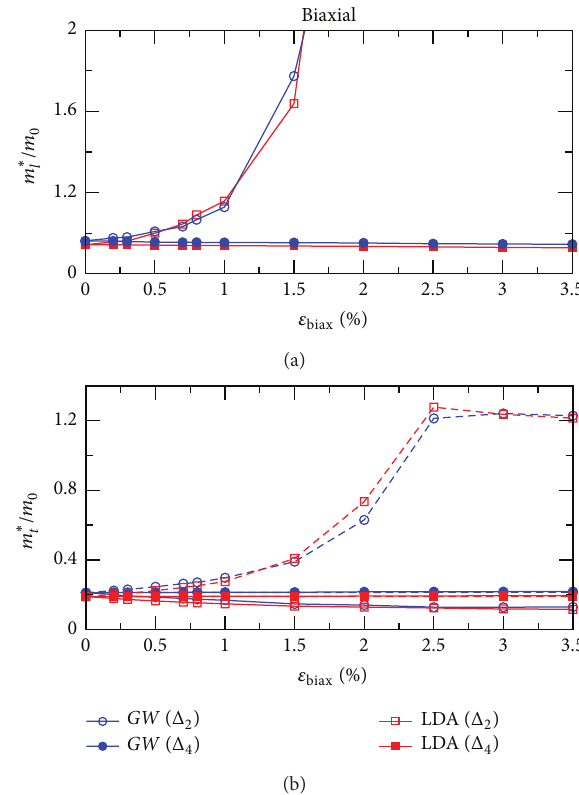
Figure 6: Longitudinal (a) and transverse (b) components of the electron effective massinsilicon asa function oftensilebiaxial strain in the (110) plane. The solid and dashed lines distinguish the two transverse elements of the mass